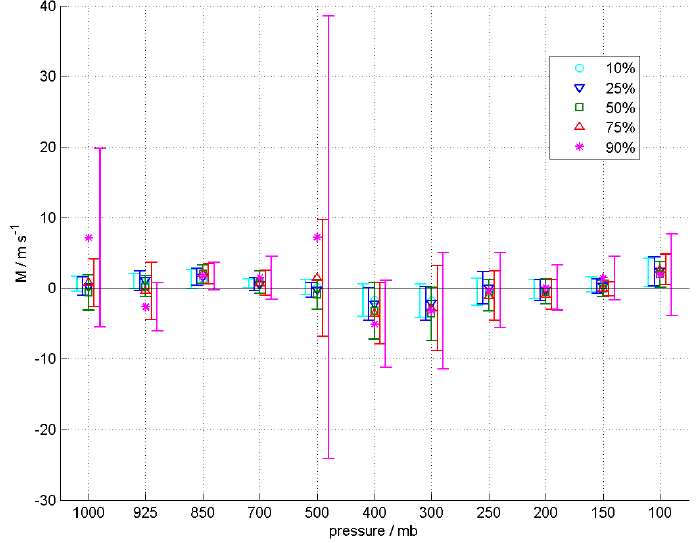
Figure 8. Results and vertical profile for the coefficient M at the five percentiles: 10%, 25%, 50%, 75%, and 90%. The error bars shown are for the 98% confidence interval. and 90%. The error bars shown are for the 98% confidence interval.